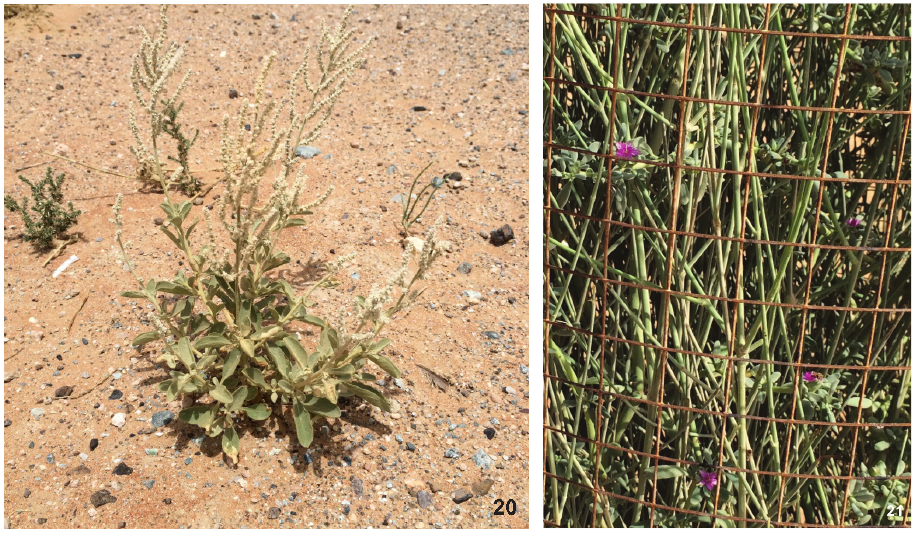
Figure 20–21. 20 Amaranthaceae, Aerva javanica 21 Aizoaceae, Sesuvium verrucosum in tree